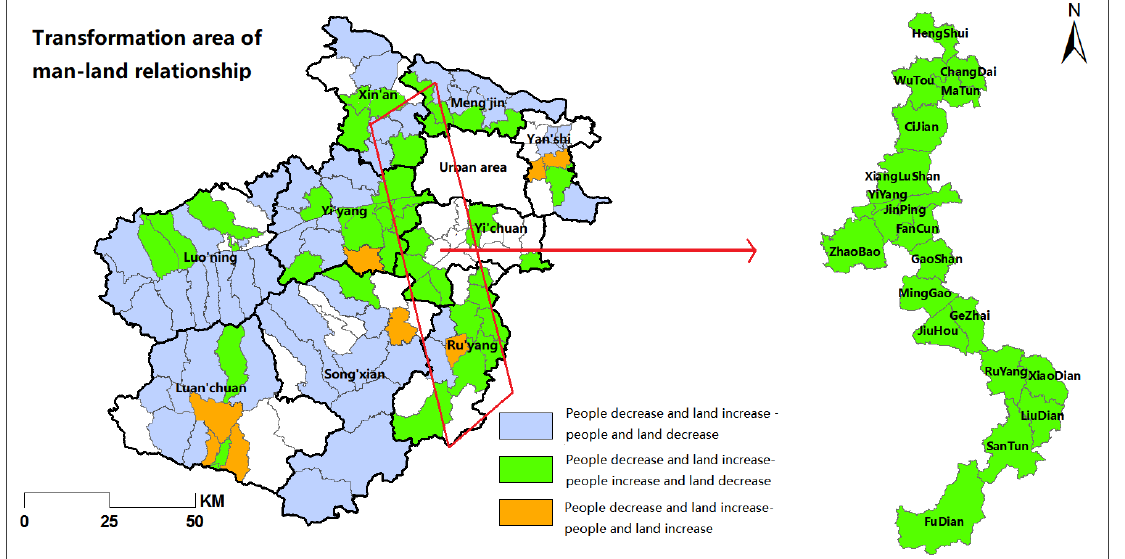
Figure 9. The location of the typical sample area of people decrease and land increase — people increase and land decrease.